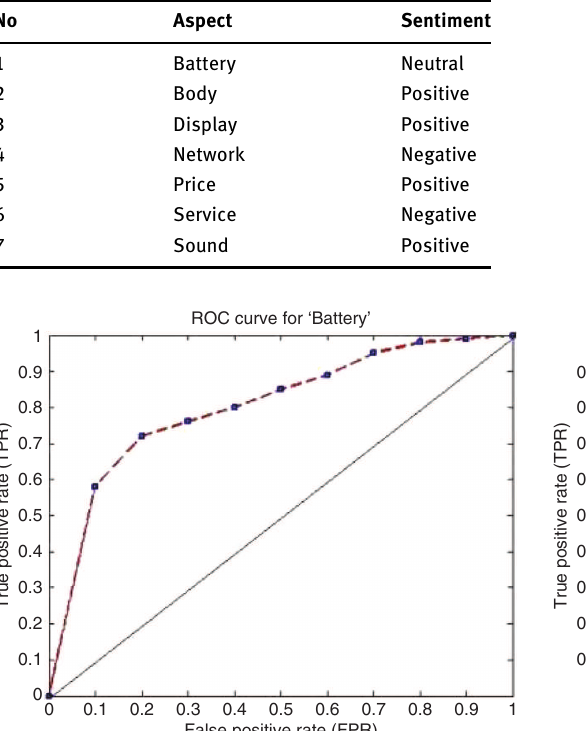
Table 5: Result of Aspect-Oriented Sentiment Analysis.